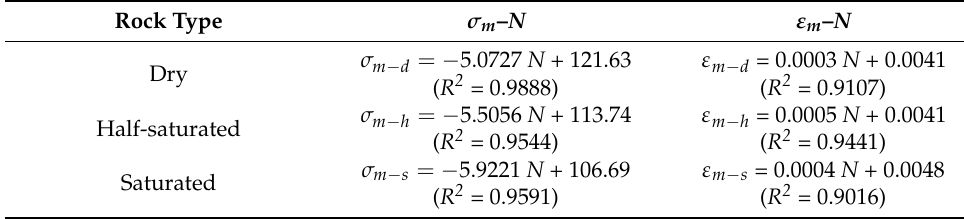
Table 2. Relationship between σ m , ε m , and N .